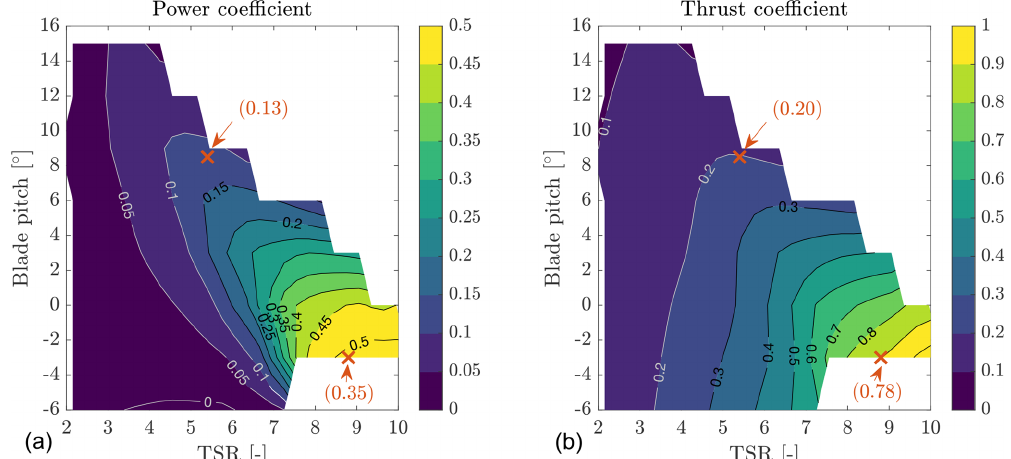
Figure 3. Map of the power and thrust coefficients of the turbine model measured in steady wind with U ∞ = 4ms − 1 . The “X” marks correspond to the turbine operating conditions of Table 4, and the coefficient values obtained in tests with fixed turbine are reported in brackets.